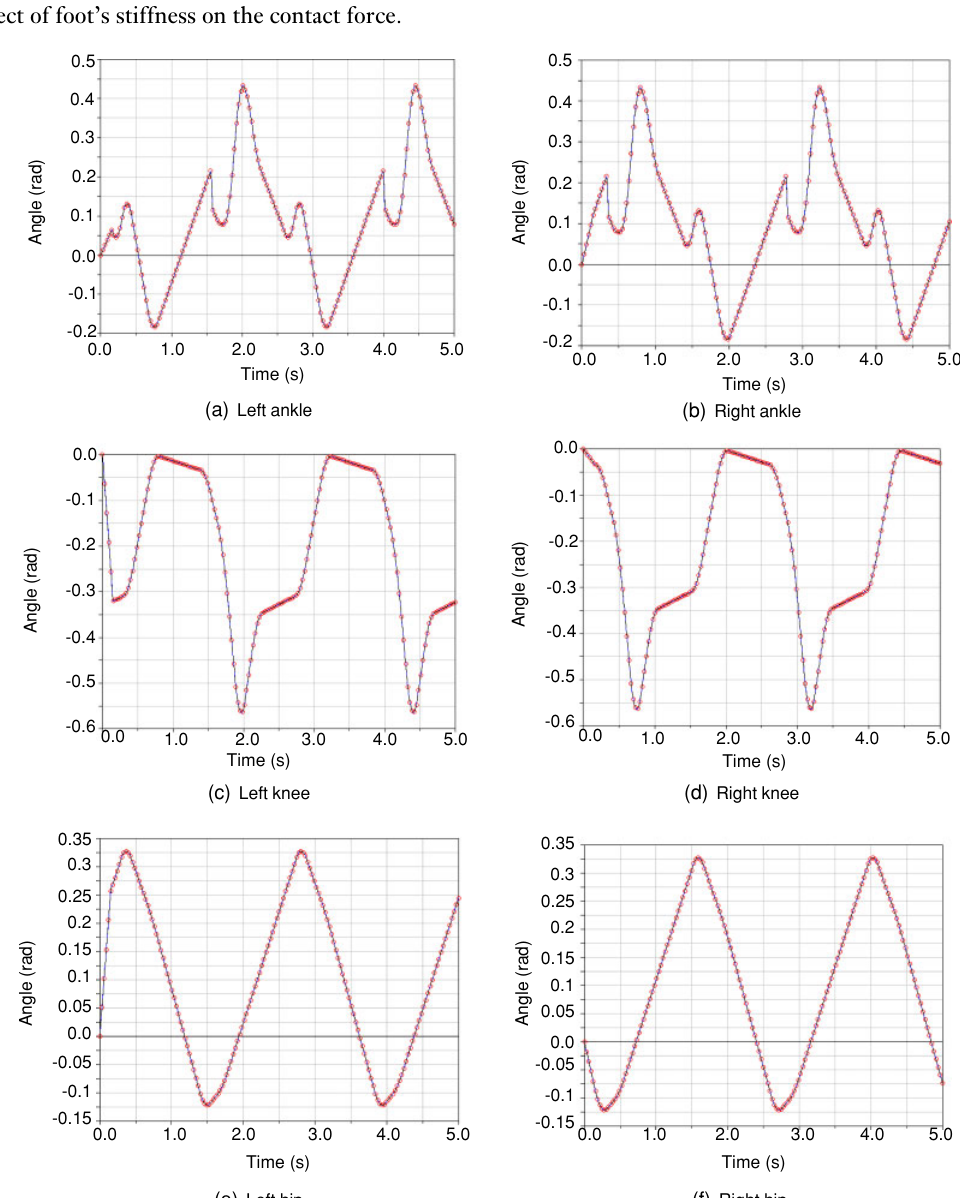
Figure 11 HMCD interpolated by using Akima splines.